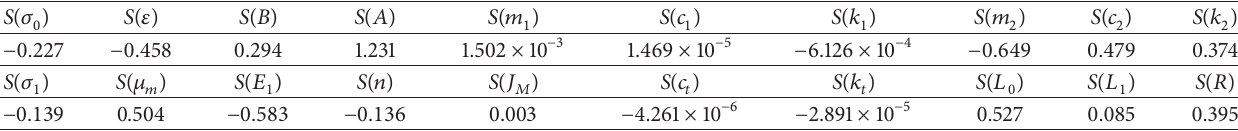
Table 5: Relative sensitivity factors for the following